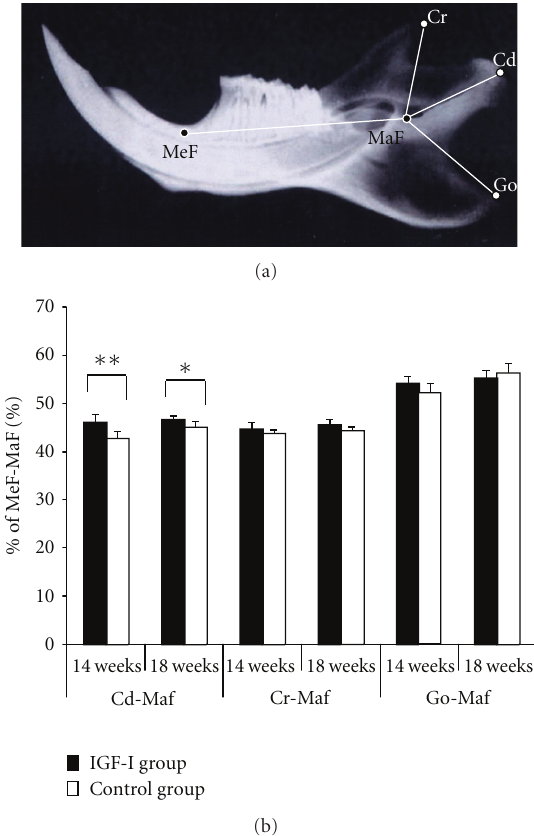
Figure 6: (a) Lateral cephalometric image showing the basal points for mandibular morphological analysis. MaF: most inferior point of the mandibular foramen; MeF: mental foramen; Cd: most posterior point of the condyle; Cr: tip of the coronoid process; Go: tip of the angular process. (b) Mandibular morphological change as a percentage of MeF-MaF in the same animal. Data represent the mean ± SD of six rats ( ∗ P < 0 . 05, ∗∗ P < 0 . 01 versus control), adapted from a previous report [10].